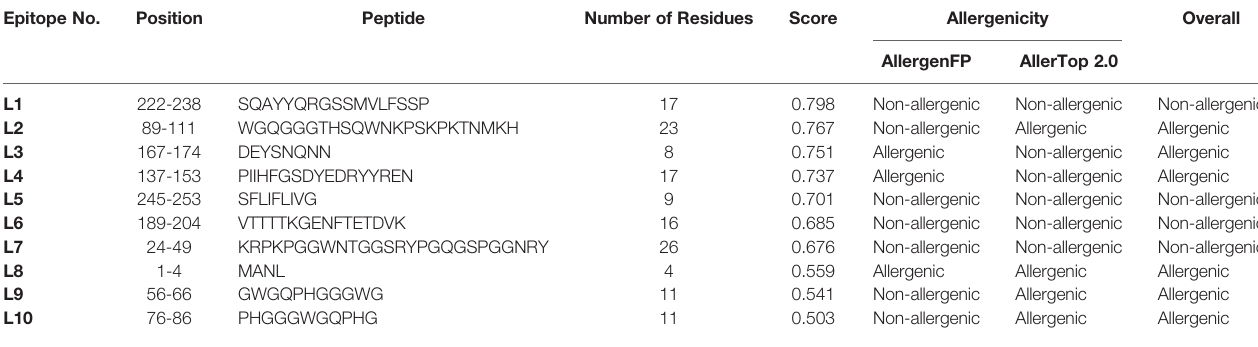
TABLE 1 | Linear B cell epitopes and their toxicity and allergenicity from the three-dimensional structure of the human major prion protein. Epitope